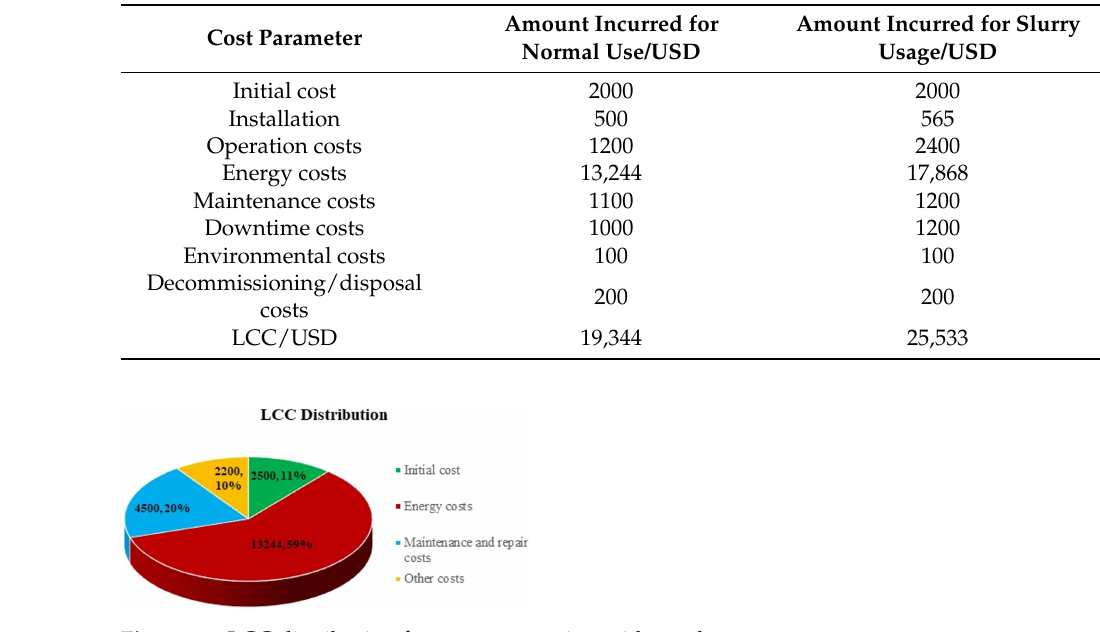
Figure 20. LCC distribution for pump operating without slurry.